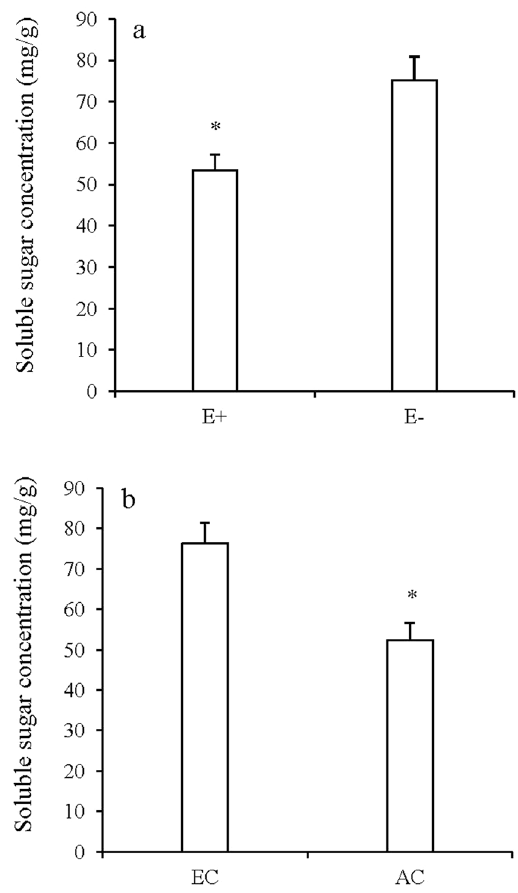
Figure 5. Soluble sugar concentration of Festuca arundinacea under different endophyte ( a ) and CO 2 treatments ( b ). * Meant significant difference at 0.05